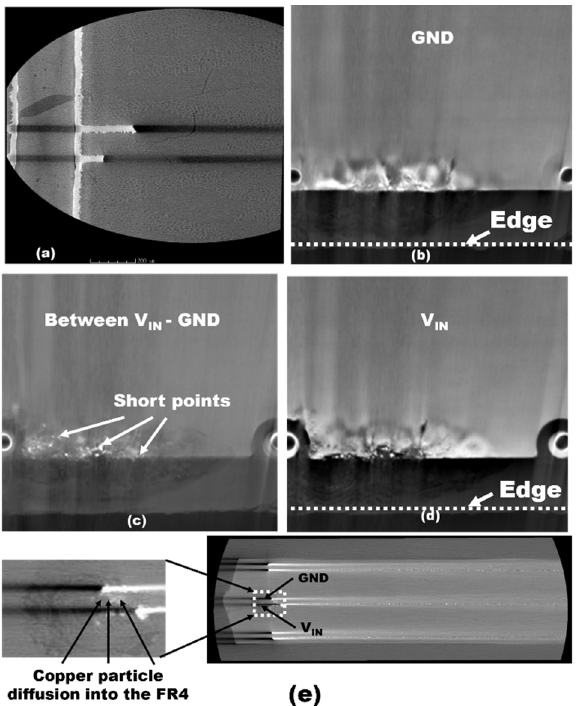
Figure 4. A 3D X-ray of the PCB that shows the cross-section of the PCB. The propagation of the cracks and the movement of copper from the V IN layer to the GND layer due to the presence of the water layer and electric field can be seen: ( a ) shows the formation of crack lines before the resistance between them begins to decrease; ( b , d ) are the plane of the GND and V IN layer, respectively, as extracted from the 3D X-ray; ( c ) is the plane in the middle of the GND layer and V IN layer as extracted from the 3D X-ray where the white arrows represent copper particles; ( e ) side view of the PCB showing the short point in between the V IN layer and GND